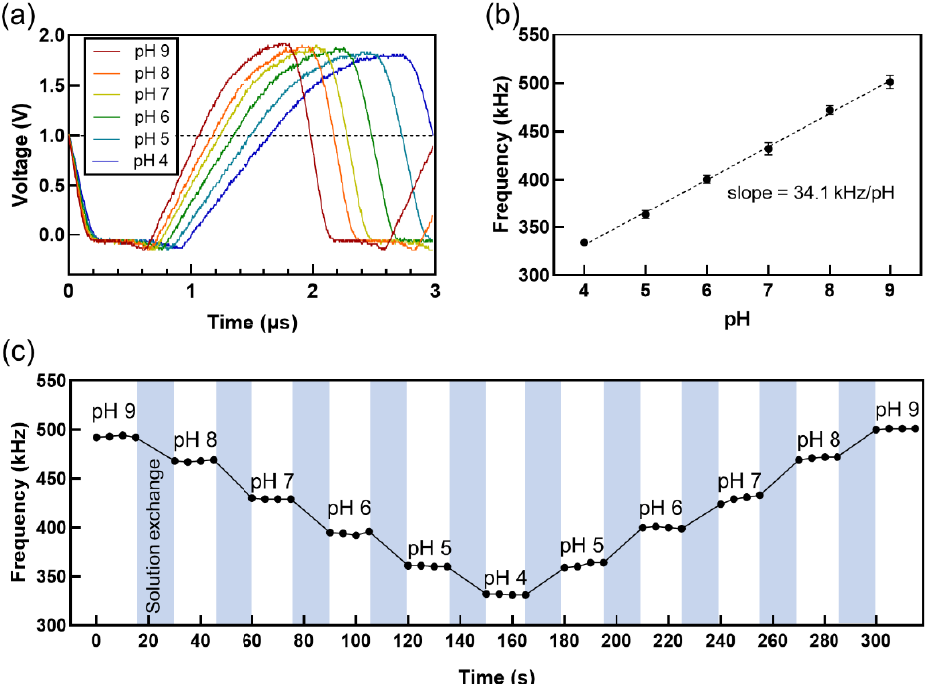
Figure 2. pH sensing characteristics. ( a ) Output waveform of ring oscillator as a function of pH. Starting point of each curve overlapped at 0 s. Dotted line provides visual guidance of shift in period (inverse of frequency) due to pH. ( b ) Oscillation frequency vs. pH, showing linear slope of 34.1 kHz/pH. ( c ) Time-resolved pH measurement. pH sensing results confirmed ability of proposed sensor in detecting changes in surface potential.